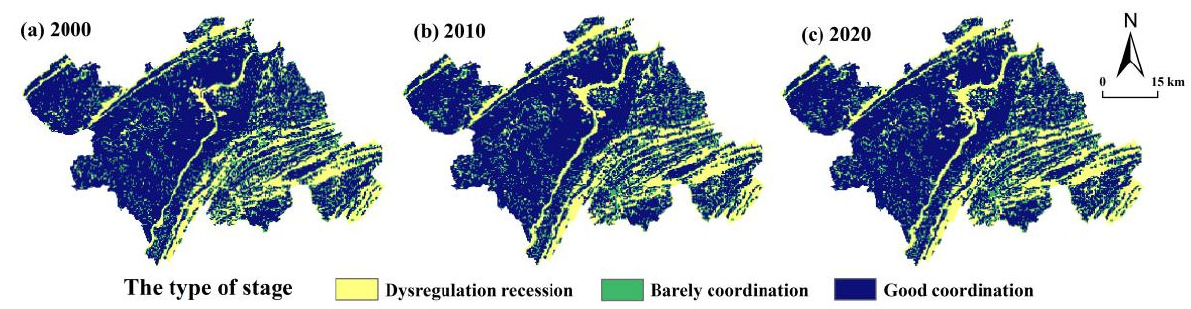
Figure 6. Coupling coordination degree of the PLEFs in 2000(a), 2010(b), and 2020(c). Regarding the CCD of PEF, Wanzhou District was in a moderate coordination